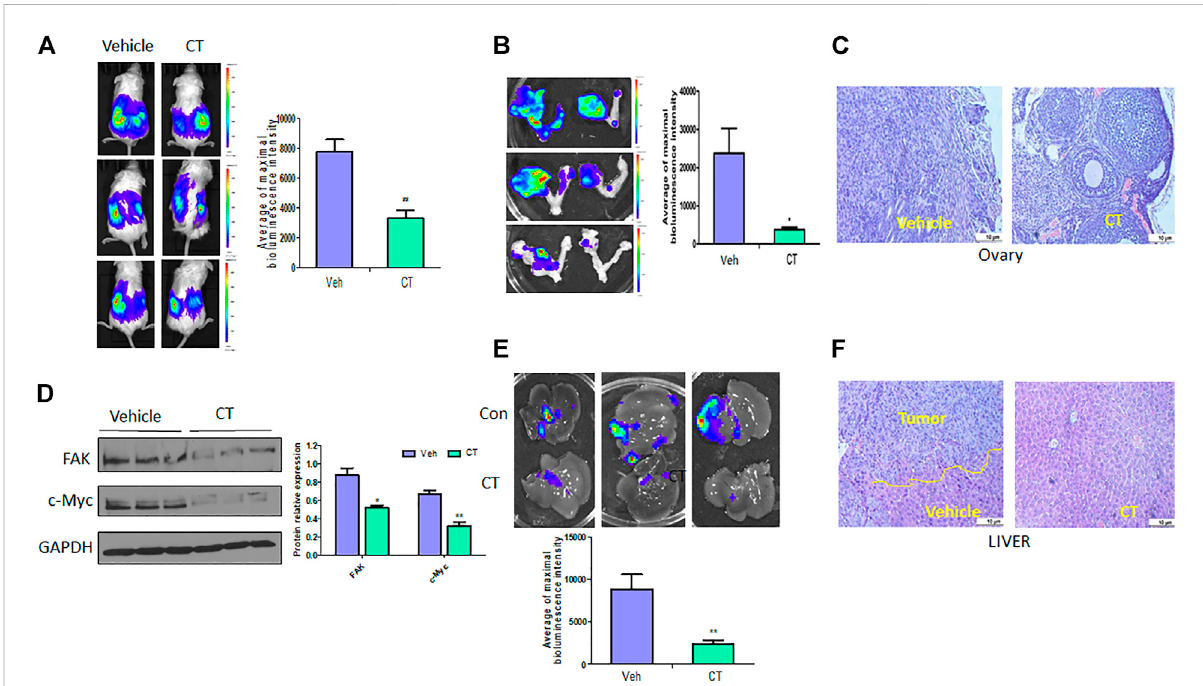
FIGURE 8 CT inhibits ovarian tumor growth and metastasis. (A,B) Live bioluminescence imaging of mice (A) and primary ovarian tumors (B) 3 weeks after CT or vehicle treatment of NSG mice intrabursally injected with WT HEY A8 cells. n = 5, * p < 0.05, ** p < 0.01. (C) Sections of primary ovarian tumors were stained with HE. (D) Immunoblot and densitometry analysis of c-Myc and FAK expression in primary tumor from three different xenografted mice treated withCT or vehicle. * p < 0.05, ** p < 0.01. (E) Metastatic tumors inliver ofmice treated with CTor vehicle. (F) Sections of metastatic tumors in liver were stained with HE. * p < 0.05, ** p < 0.01.